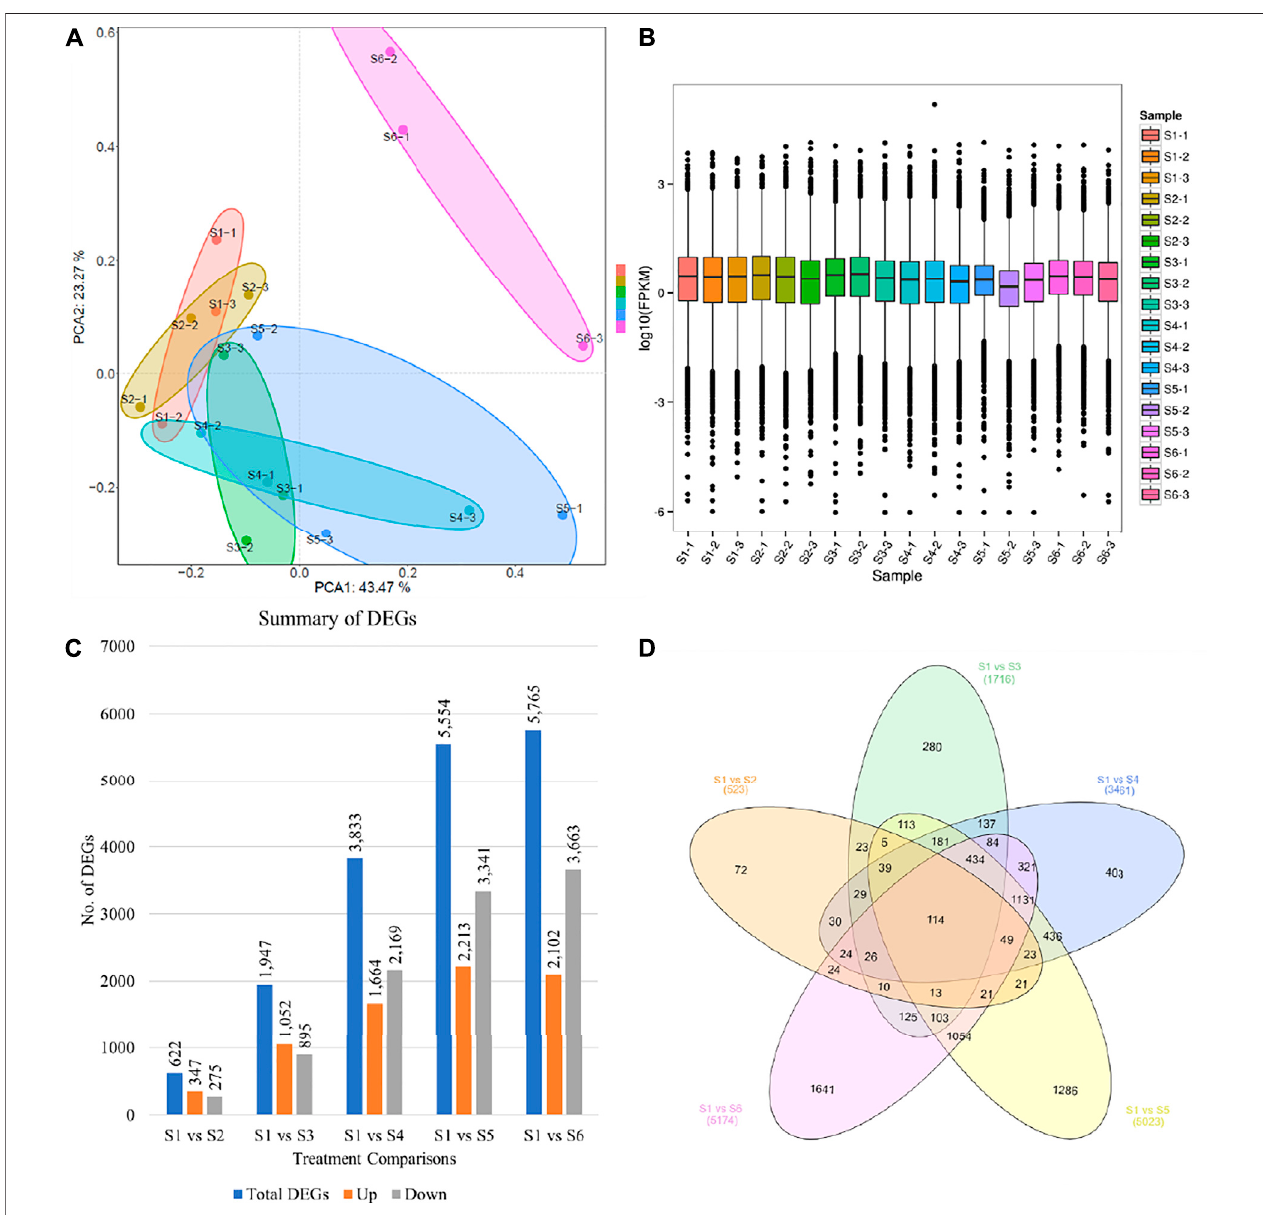
FIGURE 2 | Taro corm transcriptome comparison statistics. (A) Principal component analysis of the genes that were differentially expressed between different treatments, (B) Overall distribution of gene expression (FPKM), (C) number of differentially expressed genes between the taro samples, and (D) Venn diagram representing the number of common and speci fi c differentially expressed genes between the taro samples. S1, S2, S3, S4, S5, and S6 represent taro samples harvest after 1, 2, 3, 4, 5, and 8 months.